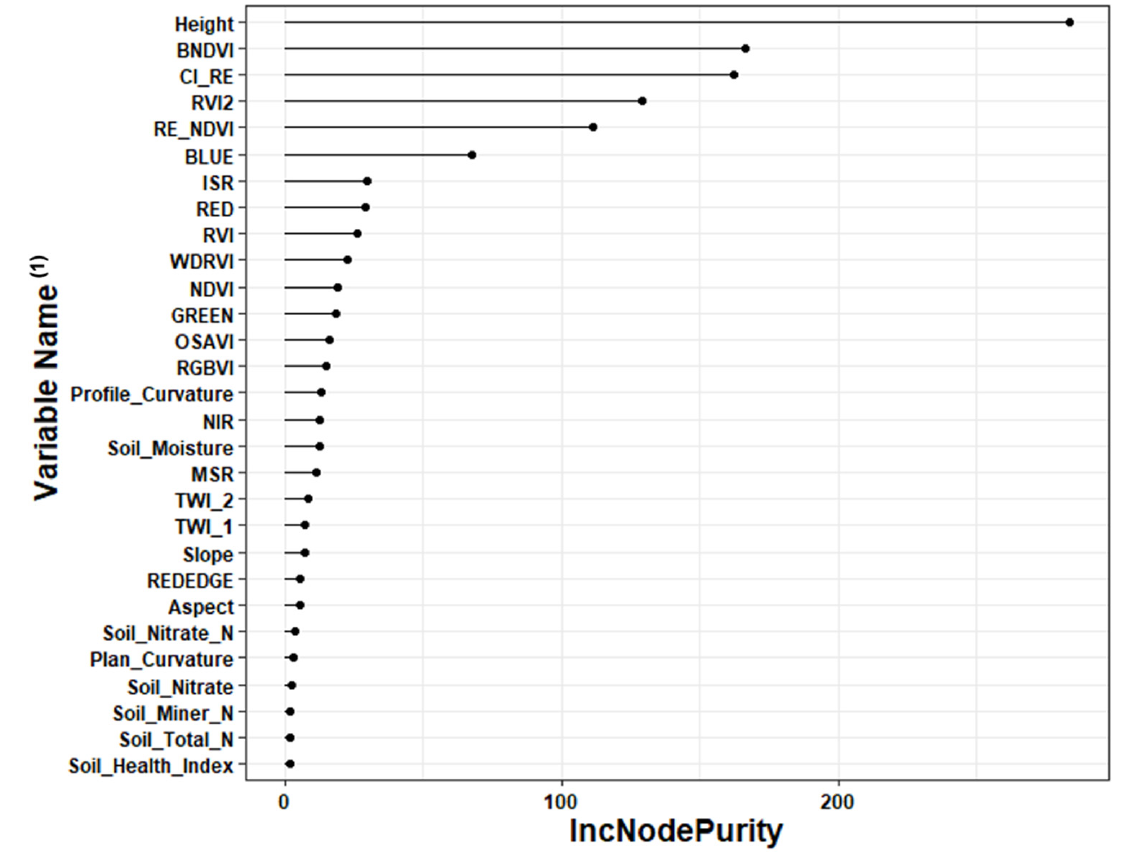
Figure 6. Variance Importance plot produced by the Random Forest model of all three dates and 30 variables, using the function varImpPlot() in R Studio. Higher IncNodePurity values indicate more impact on nitrogen. (1) Please refer to Table 1 for the full name of vegetation indices. N_Weight, plant nitrogen weight; Soil_Nitrate_N, soil nitrate nitrogen (NO3-N); Soil_Miner_N, soil mineralizable nitrogen; Soil_Total_N, water extracted total soil nitrogen; TWI_1, total wetness index #1; TWI_2, total wetness index #2.